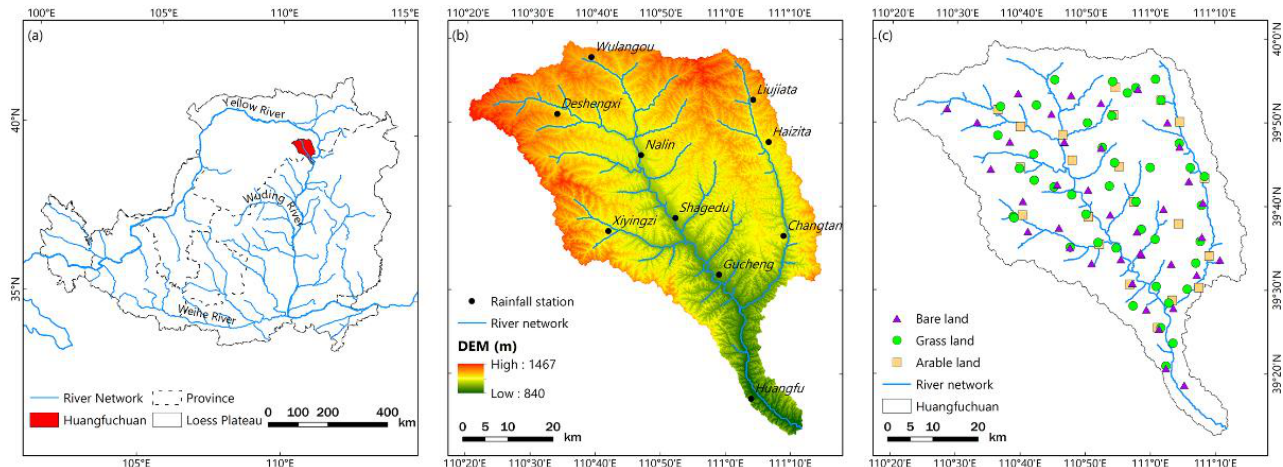
Figure 1. Location of the study area. ( a ) The Huangfuchuan watershed in the LP. ( b ) The rainfall stations in Huangfuchuan watershed. ( c ) The soil sampling points in different land uses in Huangfuchuan watershed.